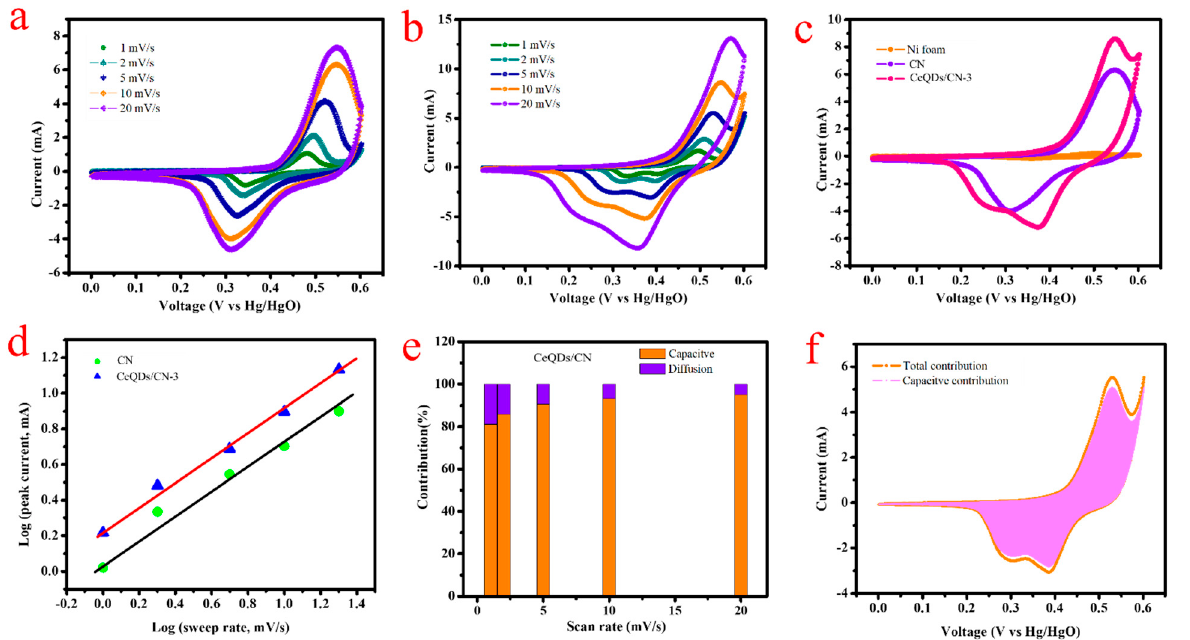
Figure 5. Three-electrode performance: CV curves of ( a ) CN, ( b ) CN/CeQDs-3, ( c ) comparison of CV curves of bare nickel foam, CN, and CN/CeQDs-3 at 10 mV/s, ( d ) analysis of b value of the cathodic and anodic peaks of CN/CeQDs-3 at different scan rates, ( e ) capacitive and diffusion contribution of CN/CeQDs-3, and ( f ) capacitive and diffusive contribution of CN/CeQDs-3 electrode at 5 mV/s.